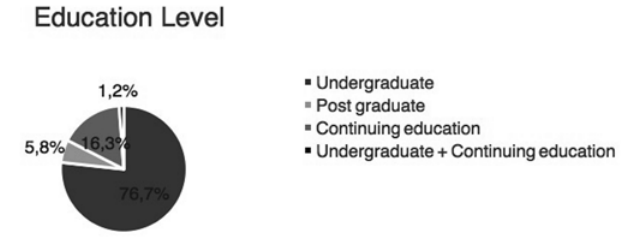
FIGURE 3 - Levels of education using e-learning